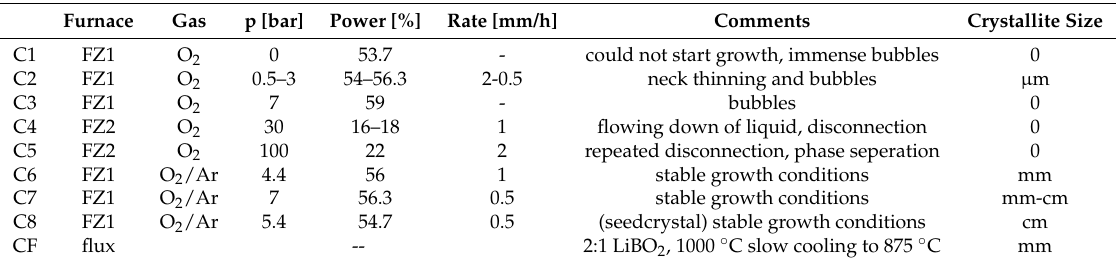
Table 1. Listed are the growth attempts of Ba 0.9 Sr 0.1 CuSi 2 O 6 using stoichiometric seed and feed rods